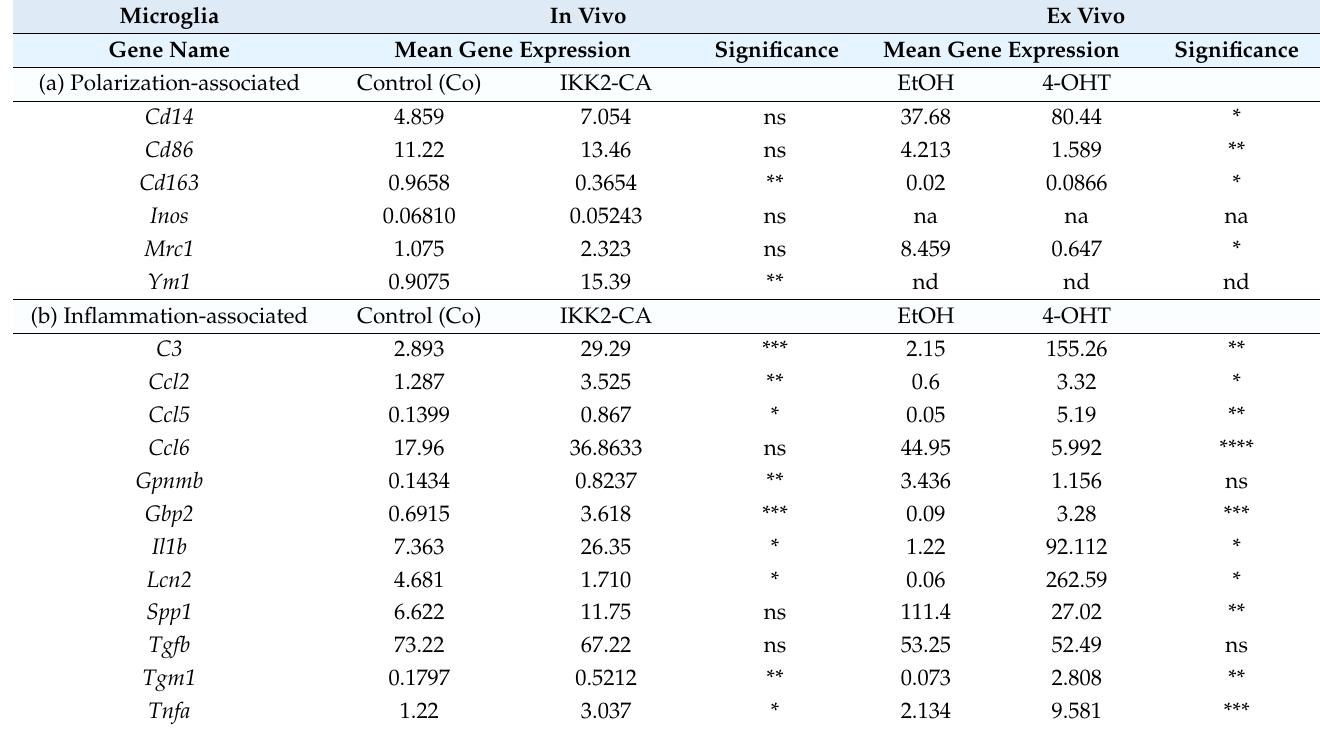
Table 1. Gene regulation of selected markers in primary microglial